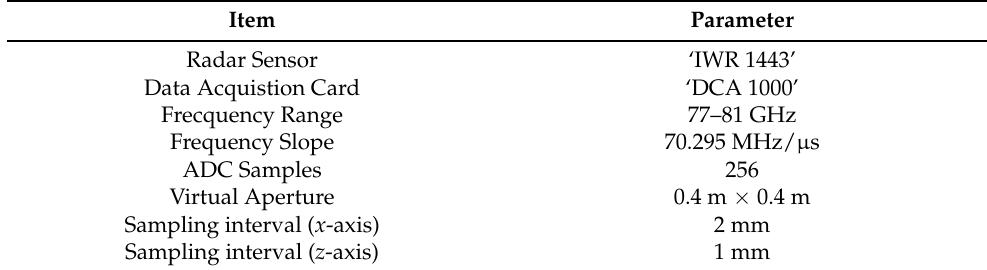
Table 1. The parameters of the experimental platform.